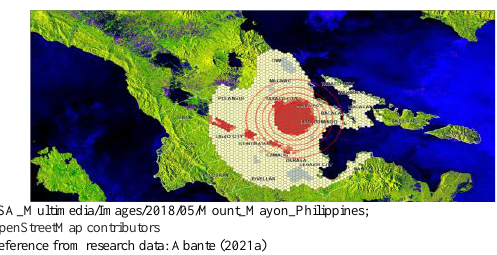
Figure 5 . Vulnerable, danger and no-build